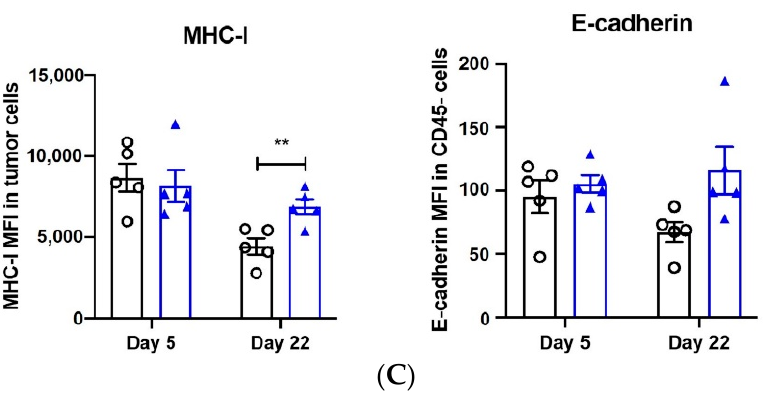
Figure 4. Q702 induces changes in immune cell populations in the tumor microenvironment. EMT6 tumor bearing BALB/c mice treated with Q702 at 30 mg/kg orally once daily. ( A ) Tumor volumes were measured 4 and 21 days after the start of treatment, and the results are shown as mean ± SEM. ( B and C ) Tumor samples were collected on days 5 and 22. ( B ) The graph shows the percentage of tumor-infiltrating cells (CD45 + ), myeloid cells (CD11b + ), M-MDSCs (CD11b + Ly6C + ), macrophages (CD11b + F4/80 + ), M1 macrophages (MHC II high CD206 low ), M2 macrophages (MHC II low CD206 high ), CD3 T cells (CD3 + ), CD8 T cells (CD3 + CD8 + ), and CD4 T cells (CD3 + CD4 + ) on days 5 and 22. ( C ) Graphs show MHC-I and E-cadherin expression levels in tumors (CD45-negative cells). * p < 0.05, ** p < 0.01, *** p < 0.001, **** p < 0.0001, unpaired Student’s t -test.